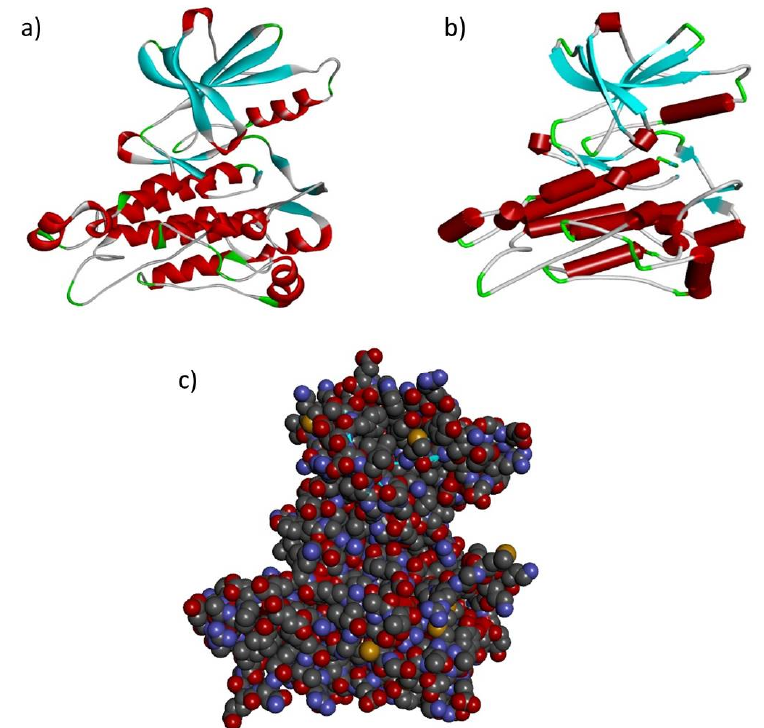
Figure 1. Pedigrees of families with TIE1 variants through three familial generations (I, II and III) in family one and through two familial generations (I and II).